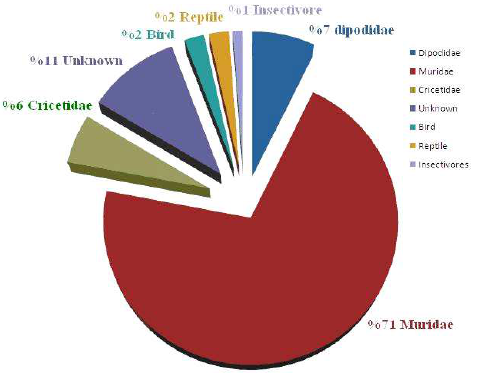
FIGURE 1 : Collecting sites of pellets in different parts of